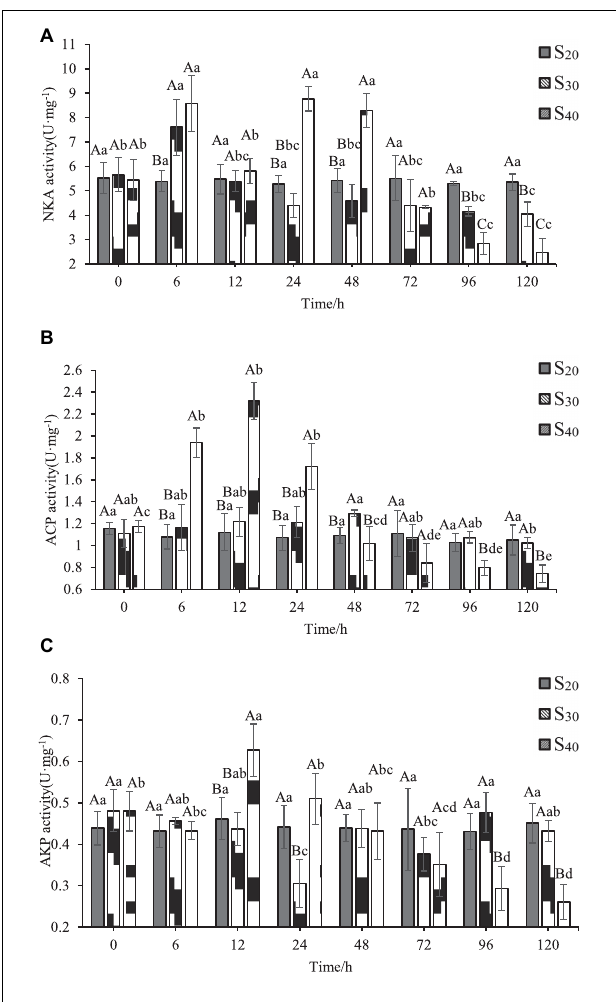
FIGURE 5 | Enzyme activities in gill of Sinonovacula constricta at different salinities and time points. (A) NKA activity, (B) ACP activity, and (C) AKP activity. Different capital letters represent significant differences between groups treated with different salinity levels at the same time point ( P < 0.05), and different small letters represent significant differences between different time points for the same group ( P < 0.05).